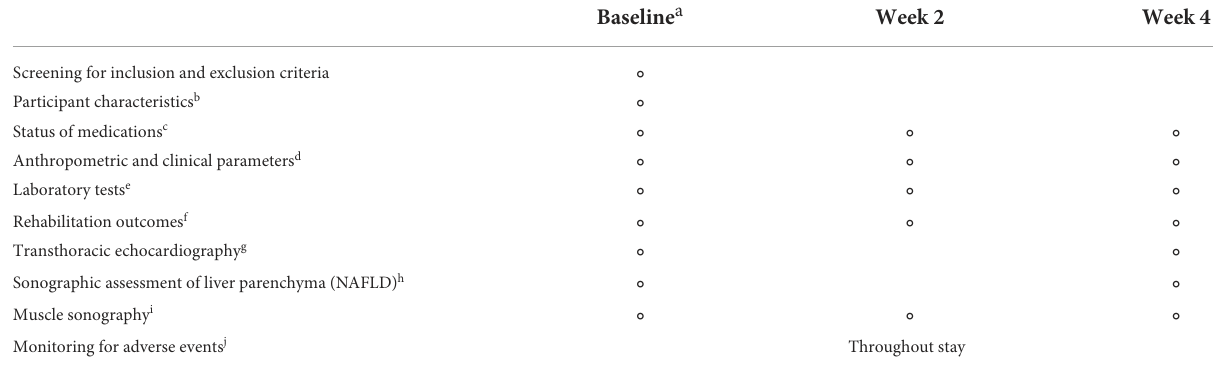
TABLE 1 Assessment time